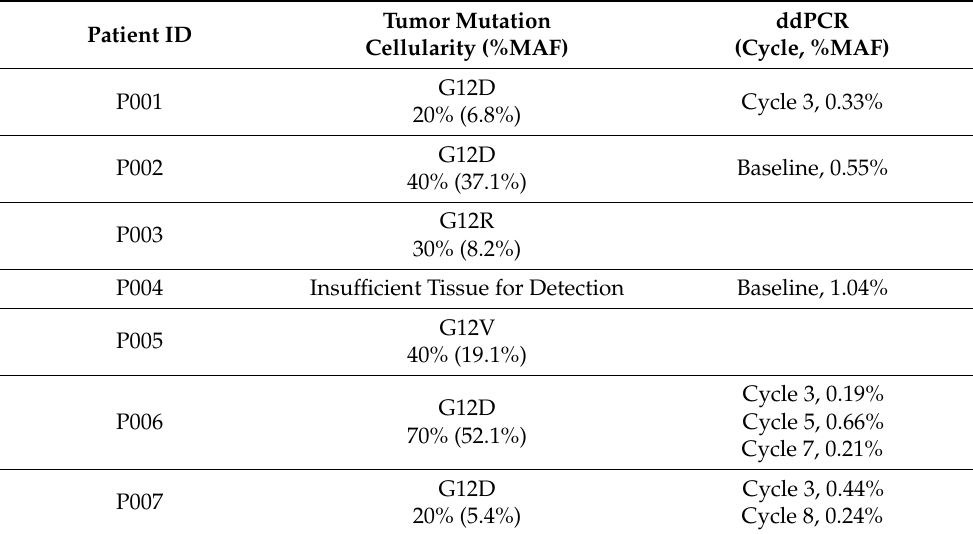
Table 3. KRAS mutation in tumor tissue or in plasma detected using ddPCR. Patient